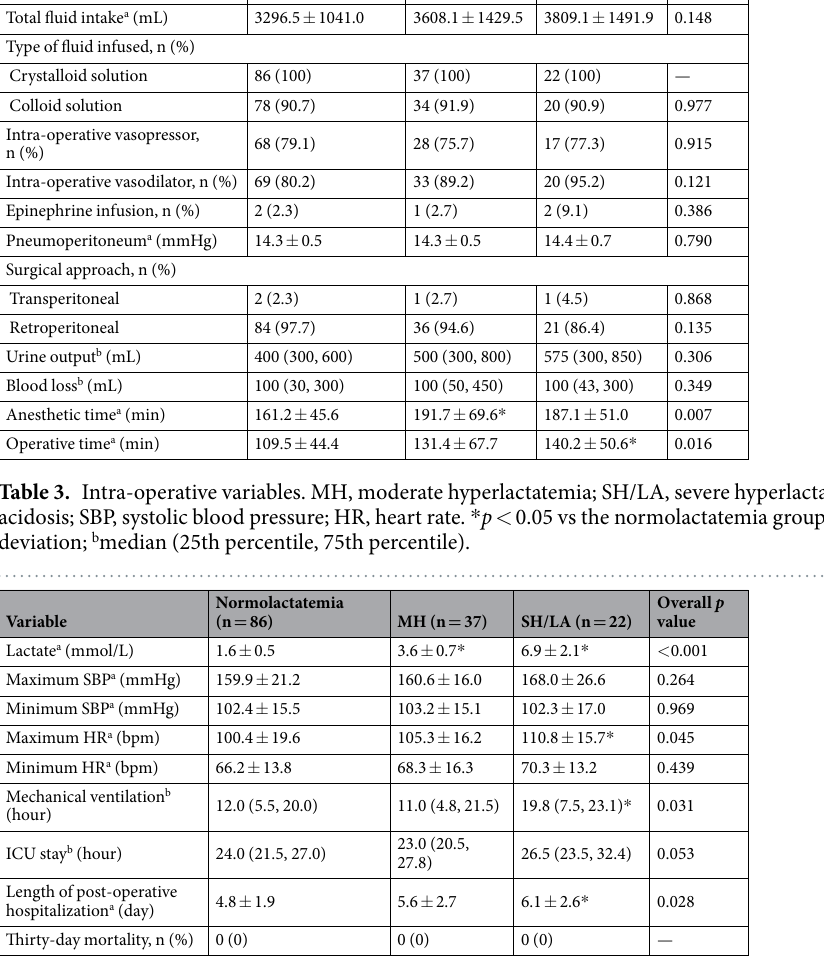
Table 4. Post-operative parameters. MH, moderate hyperlactatemia; SH/LA, severe hyperlactatemia/lactic acidosis; SBP, systolic blood pressure; HR, heart rate; ICU, intensive care unit. * p < 0.05 vs the normolactatemia group. a Mean ± standard deviation; b median (25th percentile, 75th